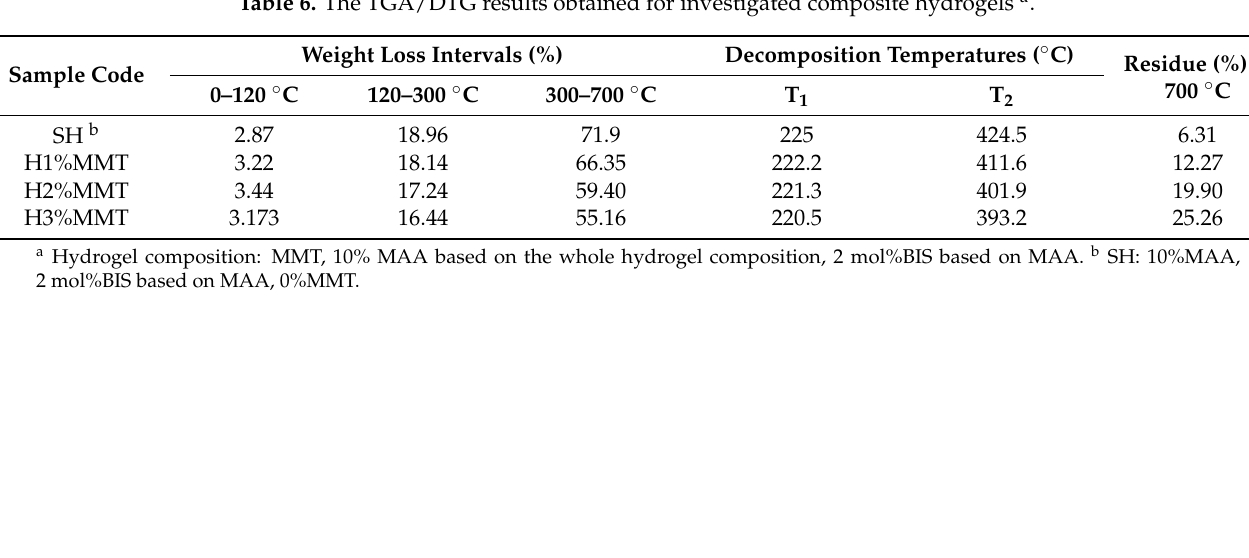
( b ) Figure 7. TGA ( a ) and TDG ( b ) curves of the obtained composite hydrogels. SH: 10%MAA, 2 mol%BIS based on MAA, 0%MMT.